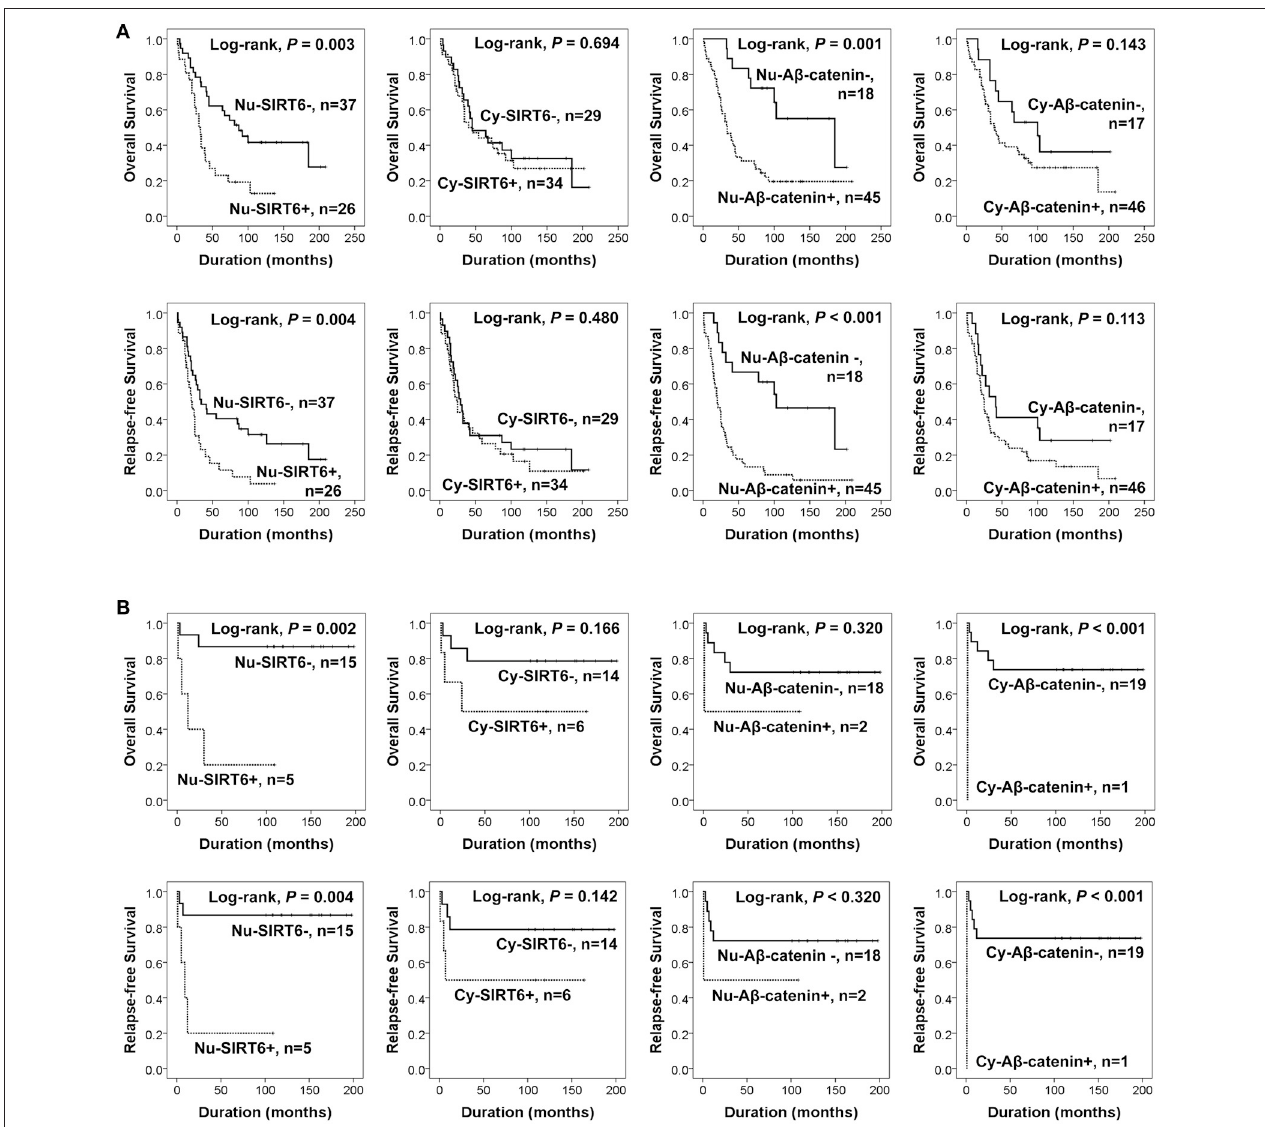
FIGURE 3 | Survival analysis according to the expression of SIRT6 and active β -catenin in the subgroups of high-grade serous carcinomas and mucinous carcinomas of the ovary. (A) Kaplan-Meier survival analysis for overall survival and relapse-free survival in the 75 high-grade serous carcinomas. (B) Kaplan-Meier survival analysis for overall survival and relapse-free survival in 20 mucinous carcinomas. Nu-SIRT6, nuclear expression of SIRT6; Cy-SIRT6, cytoplasmic expression of SIRT6; Nu-A β -catenin, nuclear expression of active β -catenin; Cy-A β -catenin, cytoplasmic expression of active β